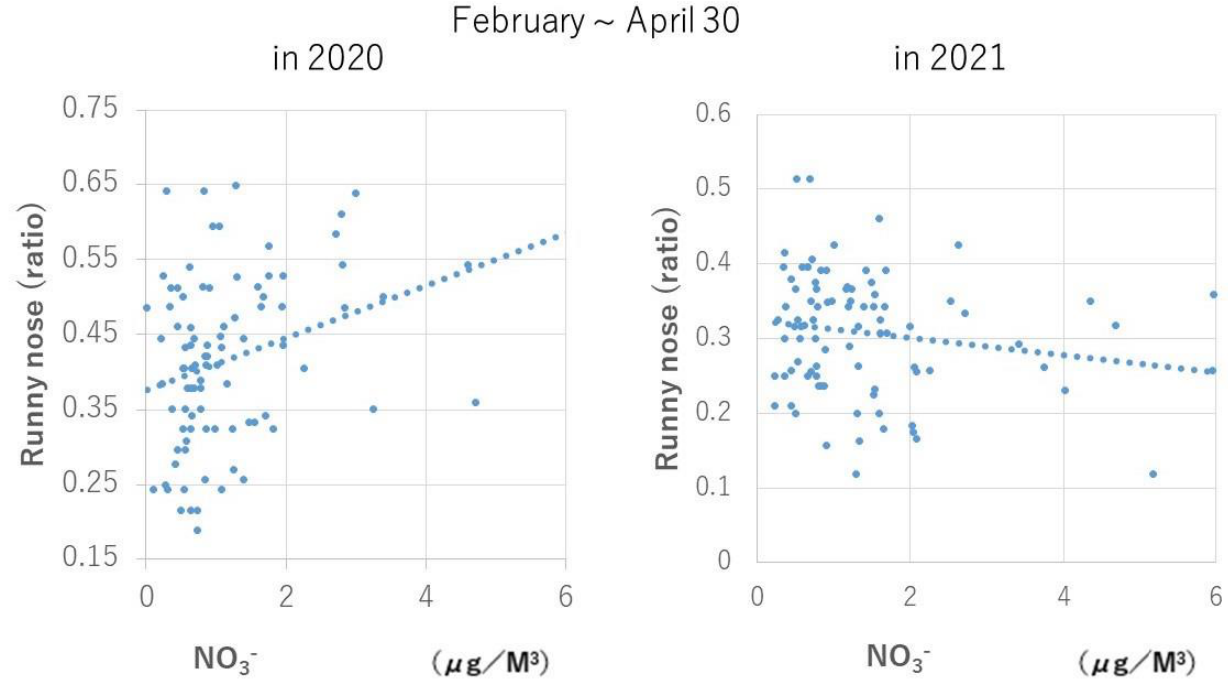
Figure 2. Relationship between daily NO 3 − concentration and frequency of runny nose symptoms. On that day, NO 3 − concentration was significantly positively correlated with a runny nose in 2020 (1 February–30 April; number of days, 90; rs = 0.3150; p = 0.0025), when the rate of mask use was 31.3%, but was no longer correlated with the symptom in 2021 (1 February–30 April; number of days, 89; rs = 0.1520, p = 0.1549), when the rate of mask use was 76.7%.